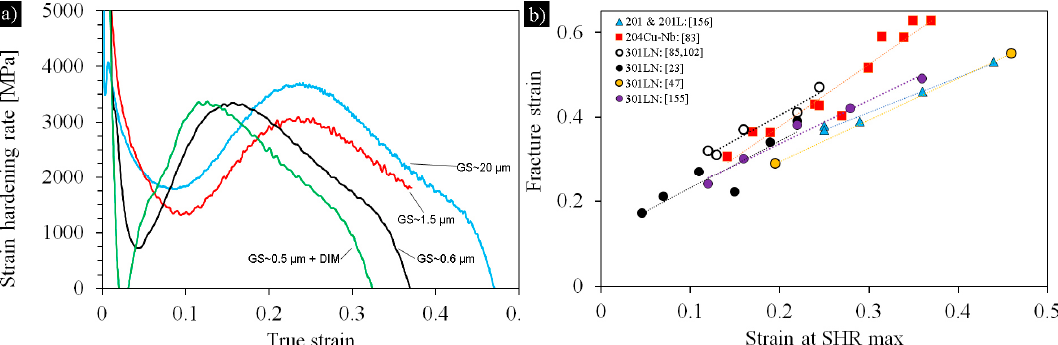
Figure 12. Strain hardening rate curves for selected AISI 301LN structures [85,87] ( a ) and the relation between fracture strain and the strain at the peak SHR ( b ). SHR = strain hardening rate.